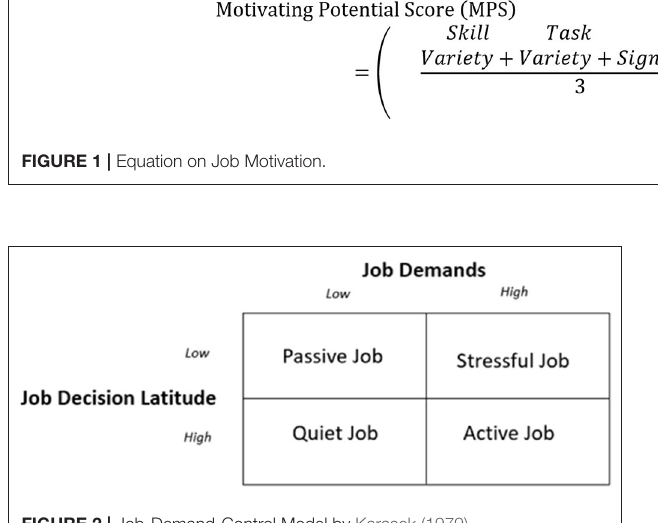
FIGURE 2 | Job-Demand-Control Model by Karasek